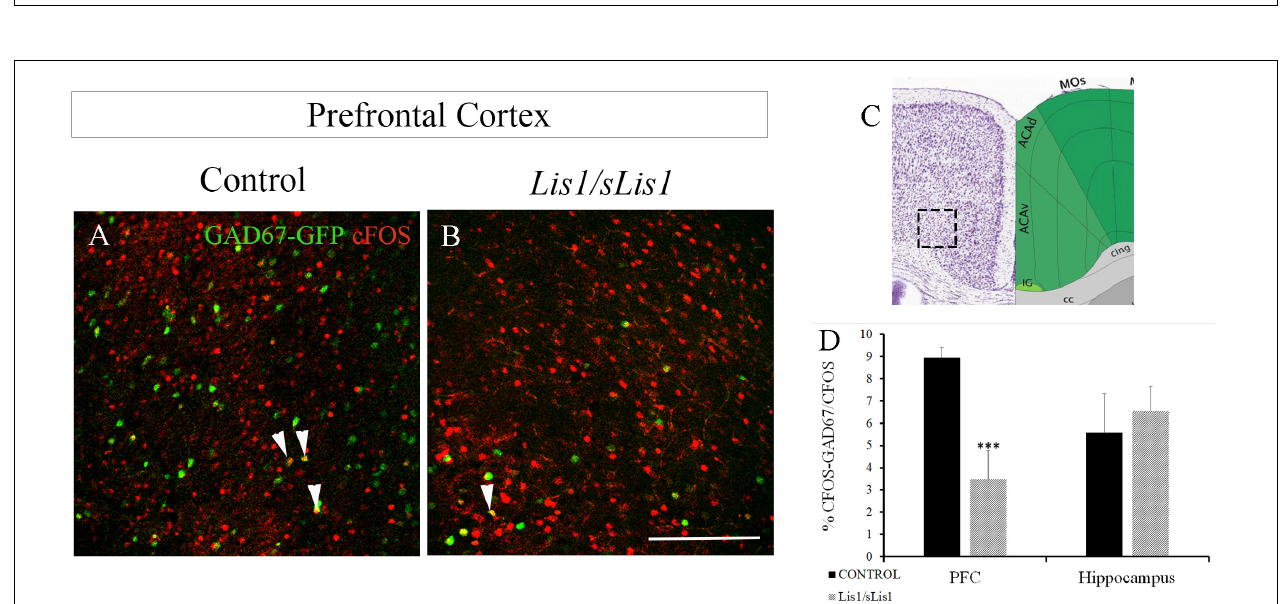
FIGURE 4 | Cells expressing cFOS in the hippocampus and PFC in Lis1/sLis1 mutant mice. (A–H) Coronal sections are immunostained with anti-cFOS antibody in the hippocampus (A–F) and prefrontal cortex (G,H) at P60. There was an increase in cFOS+ cells in the CA (A–D) and DG (E,F) regions of the hippocampus in Lis1/sLis1 mutant mice. Moreover, Lis1/sLis1 PFC also showed an increased number of cells expressing cFOS (G,H) . (I) The histogram represents the statistically significant increase in cFOS-positive cells in the areas analyzed (DG, CA, and PFC). For all panels scale bar is 200 µ m.